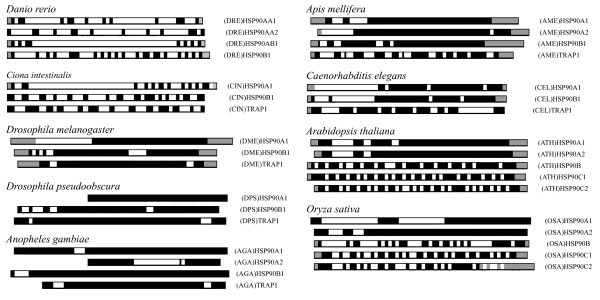
Exon splicing patterns of representative genes of the HSP90 family, identified with the genomic study and drawn to scale relative to the number of nucleotides present in each region. The black-filled rectangles depict protein-coding sequences, gray-filled rectangles represent untranslated regions, and unfilled rectangles represent introns.